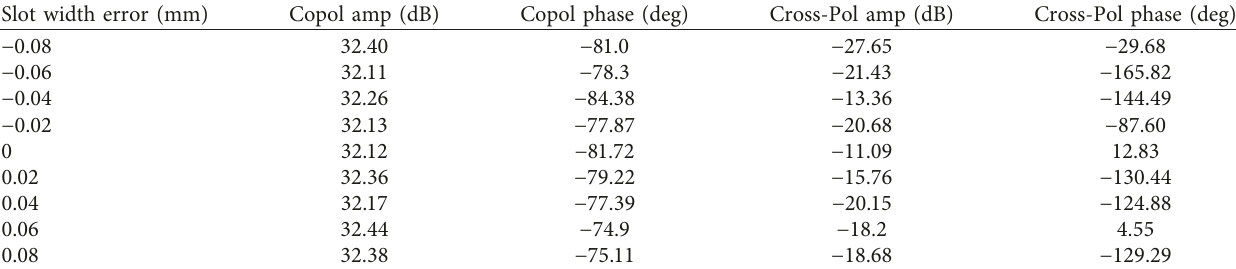
Table 2: Simulated electric field of copolarization and cross-polarization vs. waveguide slot width error. Slot width error (mm) Copol amp